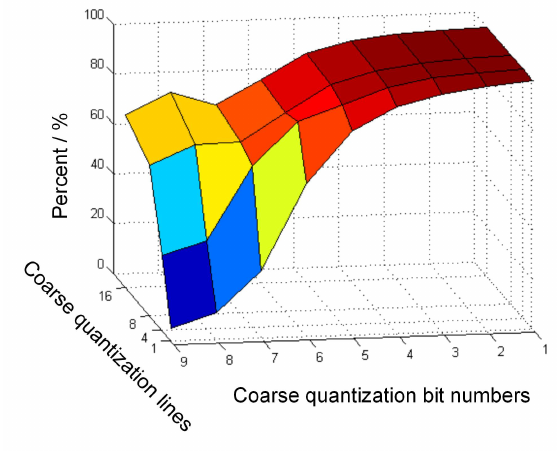
Figure 4. Comparing results between the low power accumulation scheme and the traditional accumulation